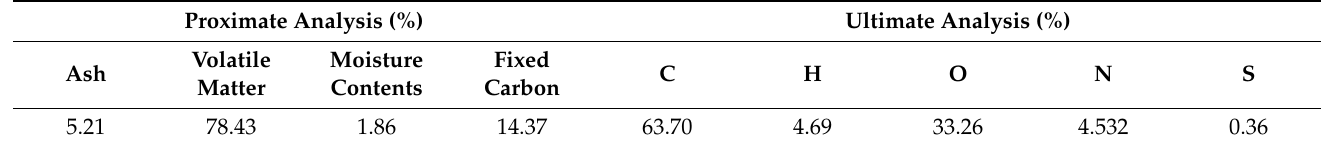
Table 1. Proximate and Ultimate analysis of waste tea.